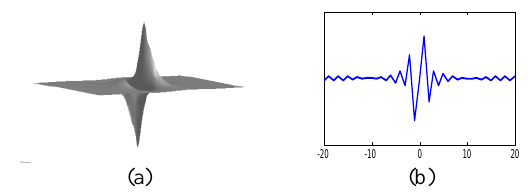
Figure 4. The log Gabor odd-symmetric wavelet. (a) the 3-D shape of this wavelet. (b) the 2-D shape of this wavelet.